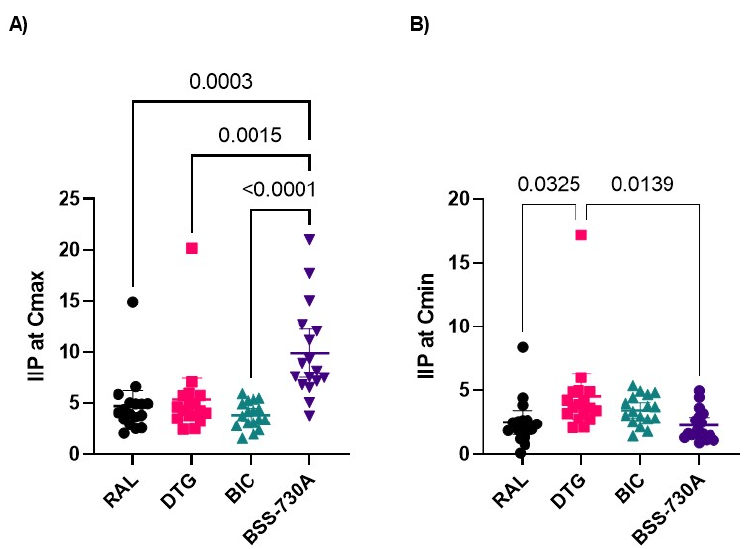
Figure 4. Comparison of IIP values of RAL, DTG, BIC, and BSS-730A at Cmax ( A ) and Cmin ( B ). Lines indicate mean values with 95% CI. One-way ANOVA with Tukey’s multiple comparisons test was used. Only p -values < 0.05 are shown.